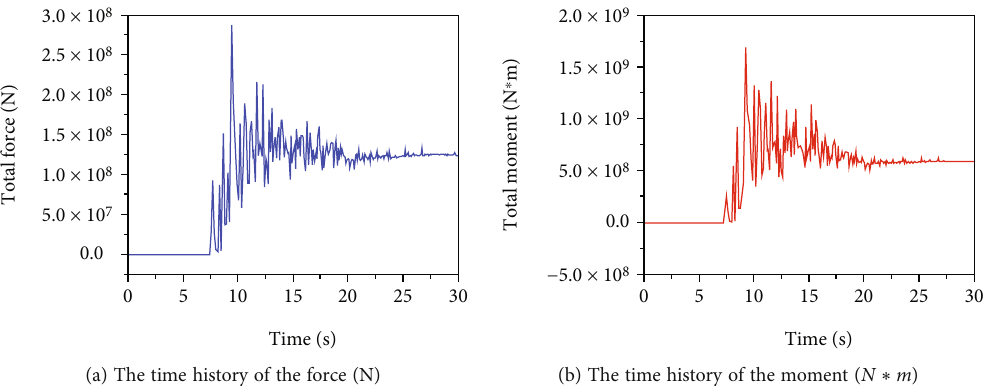
Figure 7: The time histories of the impact.